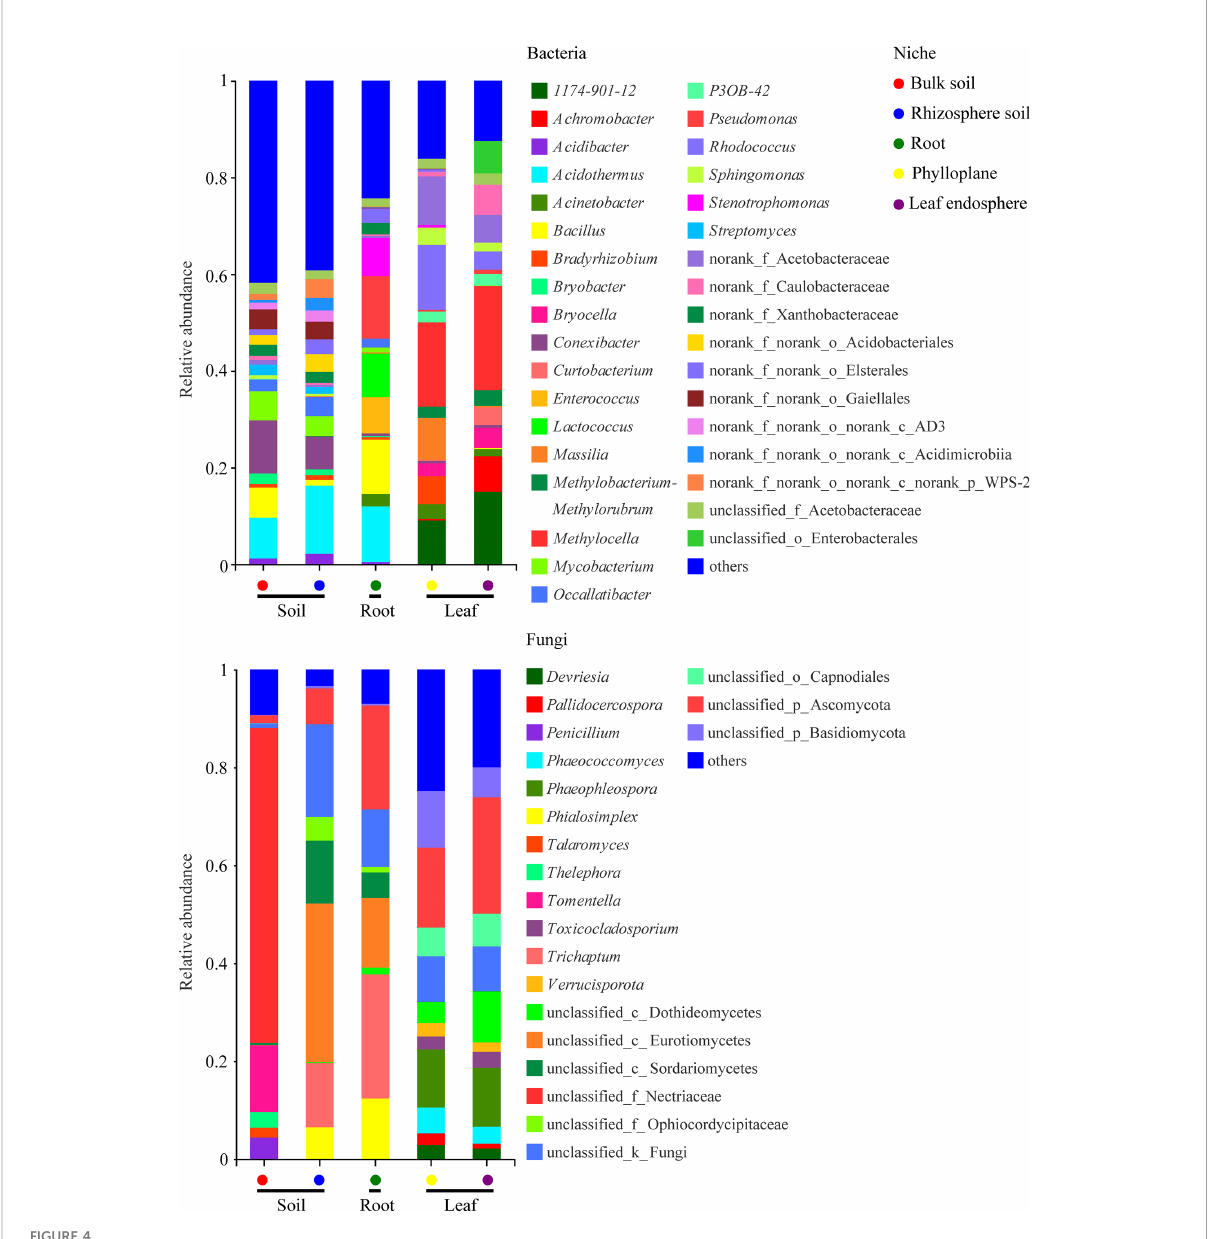
FIGURE 4 Relative abundances of the most prevalent bacterial (top) and fungal (bottom) genera in different compartment